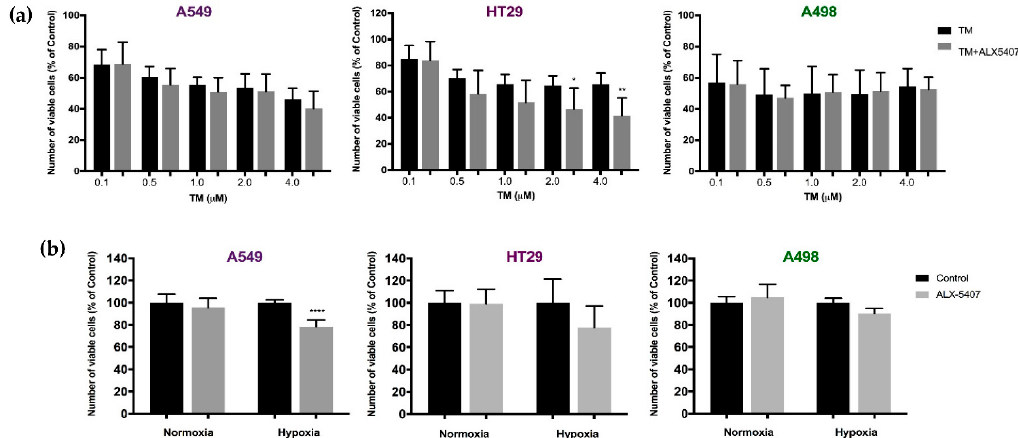
Figure 5. ALX ‐ 5407 effect on cell proliferation under stress conditions. ( a ) Number of viable cells counted following 72 h incubation with or without 120 nM ALX ‐ 5407 and further 12h treatment with 0.1, 0.5, 1, 2, and 4 μ M tunicamycin (TM) alone or in association with 120 nM ALX ‐ 5407. Data are presented as ± SEM, N = 3 and n = 12. Statistical analyses were performed by one ‐ way ANOVA with Tukey’s post hoc analysis where p < 0.05 (*) and p < 0.01 (**). ( b ) Number of viable cells counted following 72 h treatment with 120nM ALX ‐ 5407 incubated under normoxic and hypoxic conditions as percentage of untreated (control) cells according to CTB assay analysis. Data are presented as ± SEM, N = 3 and n = 9. Statistical analyses were performed by unpaired t ‐ test where p < 0.0001 (****).